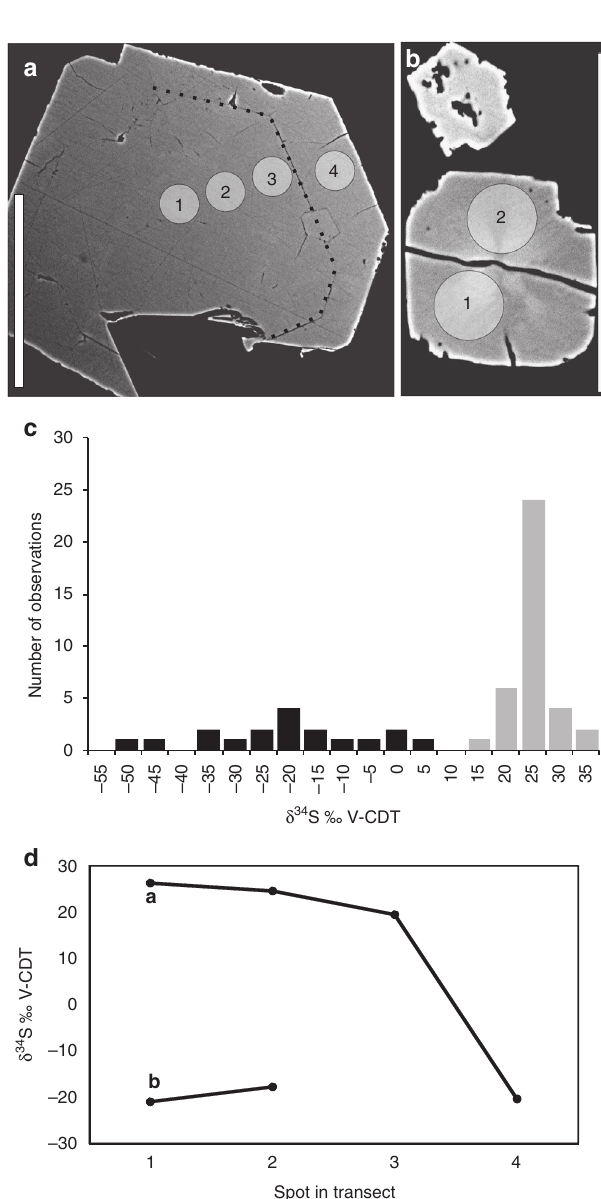
Fig. 6 S isotope characteristics of pyrite. ( a ) Examples of polished cross- section of pyrite in a back-scattered Environmental Scanning Electron Microscopy (ESEM)-image. A boundary between the fi rst and second generation of pyrite growth is visible and highlighted with a stippled line . Circles represent Secondary Ion Mass Spectrometry (SIMS)-spots (1 – 4), with values shown in d . ( b ) Polished cross-section of the young pyrite generation in a back-scattered ESEM-image. ( c ) Histogram of δ 34 S values in pyrite. Two generations are distinguished ( black bars = older, grey bars = younger). ( d ) δ 34 S values from SIMS-transects in the crystals a and b . The younger generation, 4 in a , 1 and 2 in b , has signi fi cantly lower values than the older one (1 – 3 in a ) 51 . Error bars (1 SD) are within the size of the symbols. Scale markers are 50 µ m in a and b